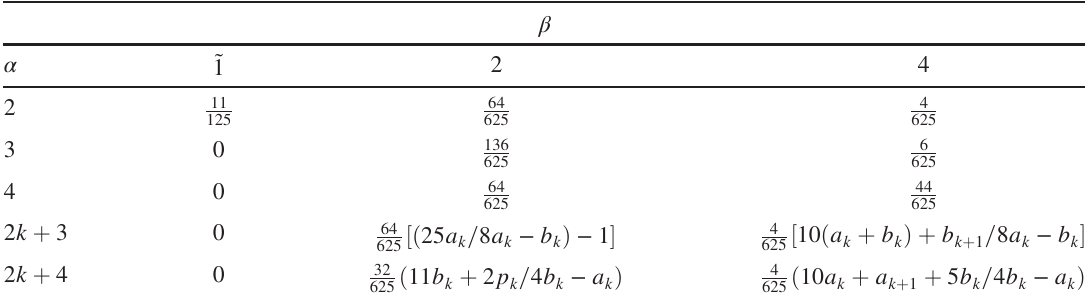
TABLE III. Transition coefficients λ α N β belongs to the edge module graph.